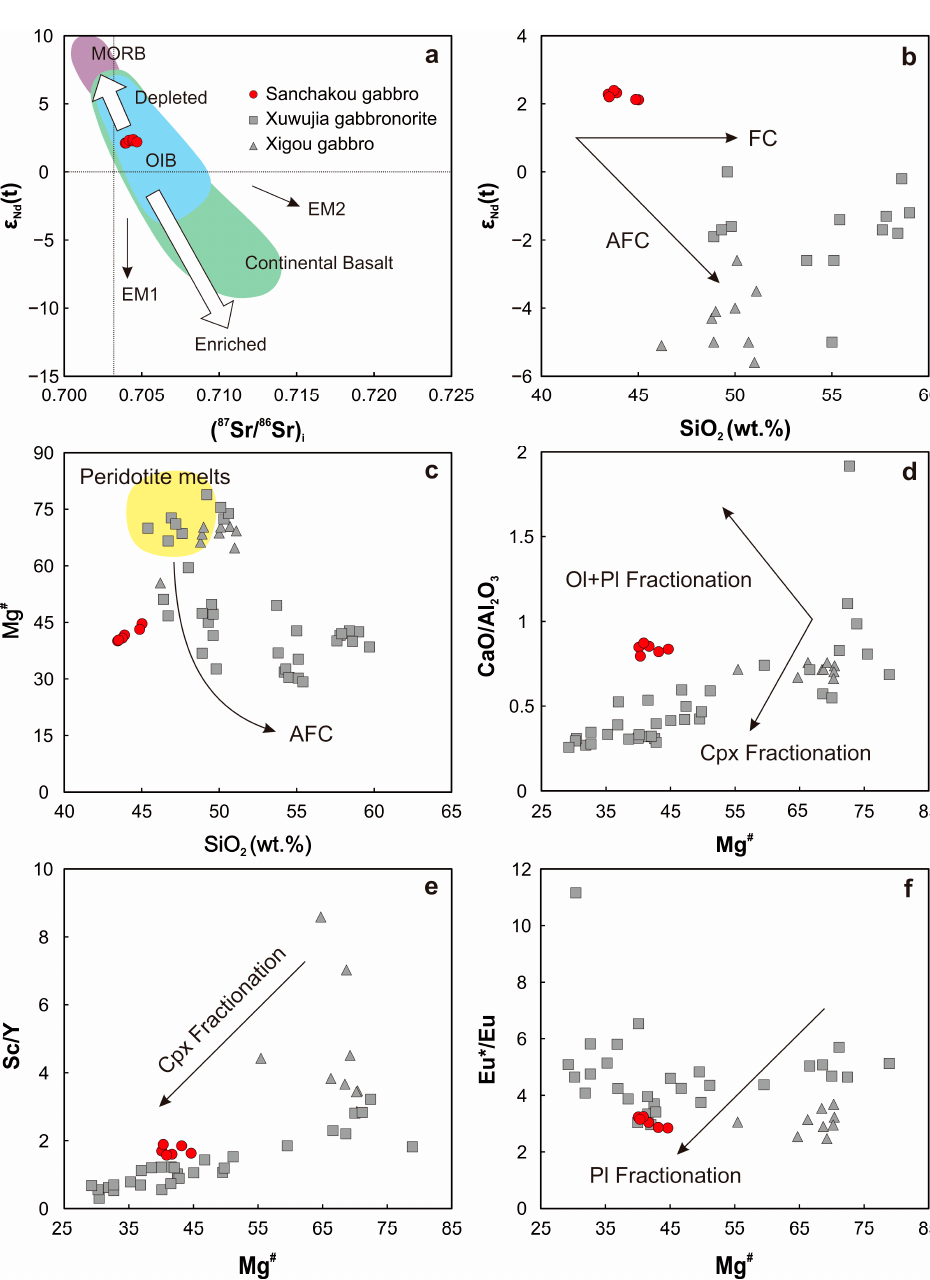
Figure 8. Geochemical diagrams of the Sanchakou gabbros. ( a ) The ε Nd (t) versus I Sr diagram (after [80]). ( b ) The ε Nd (t) versus SiO 2 diagram. ( c ) The Mg # versus SiO 2 diagram. Supposed peridotite melts and crust AFC curve are after [99]. ( d ) The CaO/Al 2 O 3 versus Mg # diagram. ( e ) The Sc/Y versus Mg # diagram. ( f ) The Eu*/Eu versus Mg # diagram. Mineral abbreviations: Cpx, clinopyroxene; Ol, olivine; Pl, plagioclase. The major and trace elemental data of Xuwujia gabbronorites and Xigou gabbros are from [35].